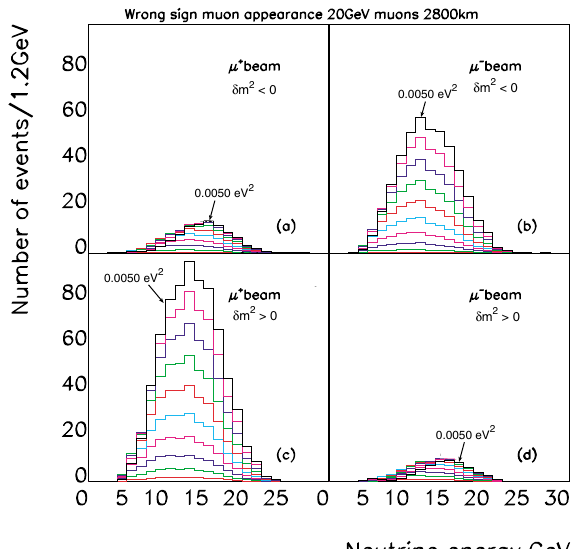
FIG. 4. (Color) The wrong-sign muon appearance rates for a 20 GeV muon storage ring at a baseline of 2800 km with 10 20 decays and a 50 kt detector for (a) (cid:3) (cid:2) stored and negative (cid:6)m 2 , (b) (cid:3) (cid:1) stored and negative (cid:6)m 2 32 , (d) (cid:3) (cid:1) stored and positive (cid:6)m 2 positive (cid:6)m 2 32 j range from 0.0005 to 0 : 0050 eV 2 in steps of 0 : 0005 eV 2 . j (cid:6)m 2 32 Matter enhancements are evident in (b) and (c).